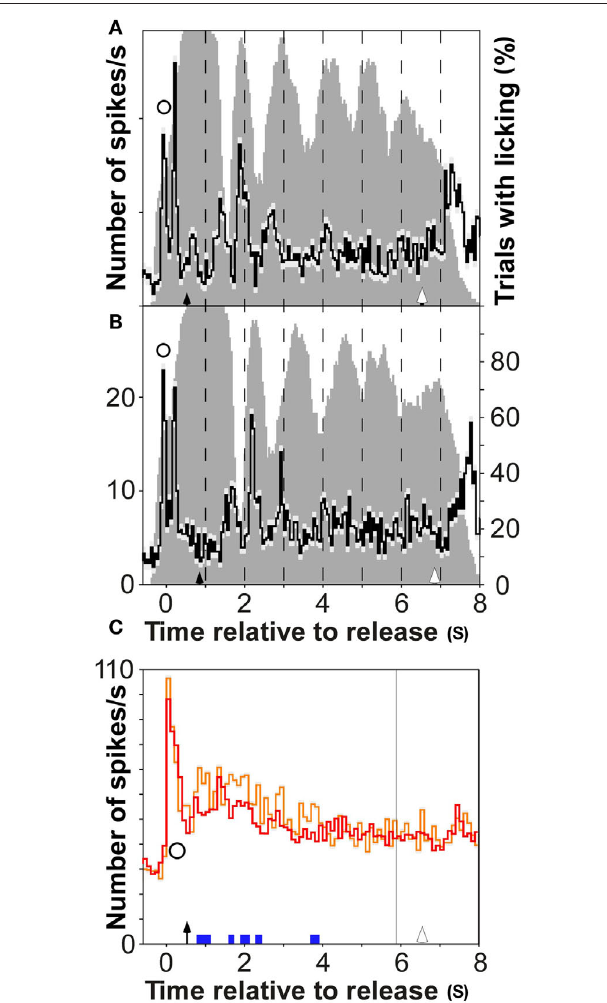
Figure 6 | (A,B) Reward-size coding of a sample multiunit in auditory cortex for two reward delays. The large reward arrived either early (530 ms, upper panel) or late (850 ms, lower panel) after bar release. Conventions as in Figure 2 . (C) Reward-size coding in auditory cortex for the large (0.22 ml, red curve, 142 trials) and extra-large rewards (0.29 ml, orange curve, 53 trials). Symbols as in Figure 2